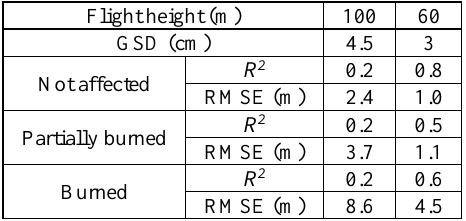
Table 3. Results from the coefficient of determination ( R 2 ) and root mean square error (RMSE) for the 100 m and 60 m flight height flights in each tree type and the overall